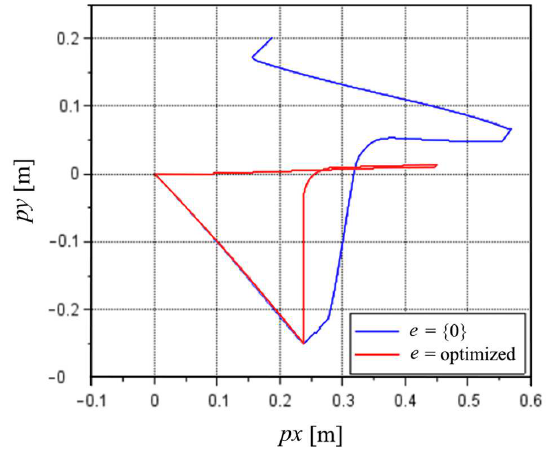
Figure 6. Comparison of the XY plane position results of the nozzle for the first cycle at 100% MS considering equal to zeros or optimized value of with the start guess values of zeros.